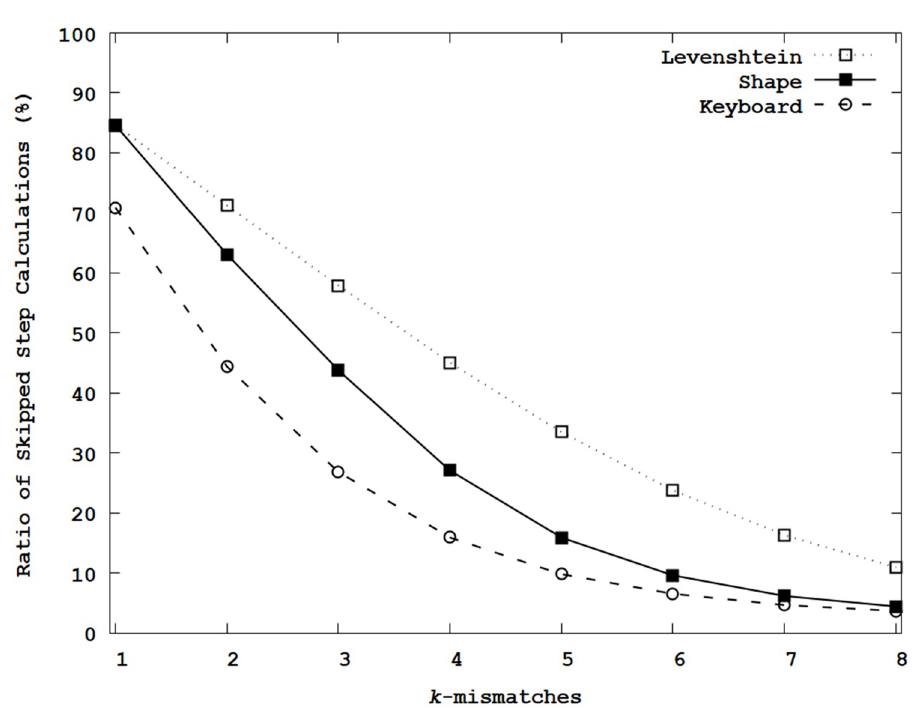
Fig 9. Ratios of skipped edit distance calculations.